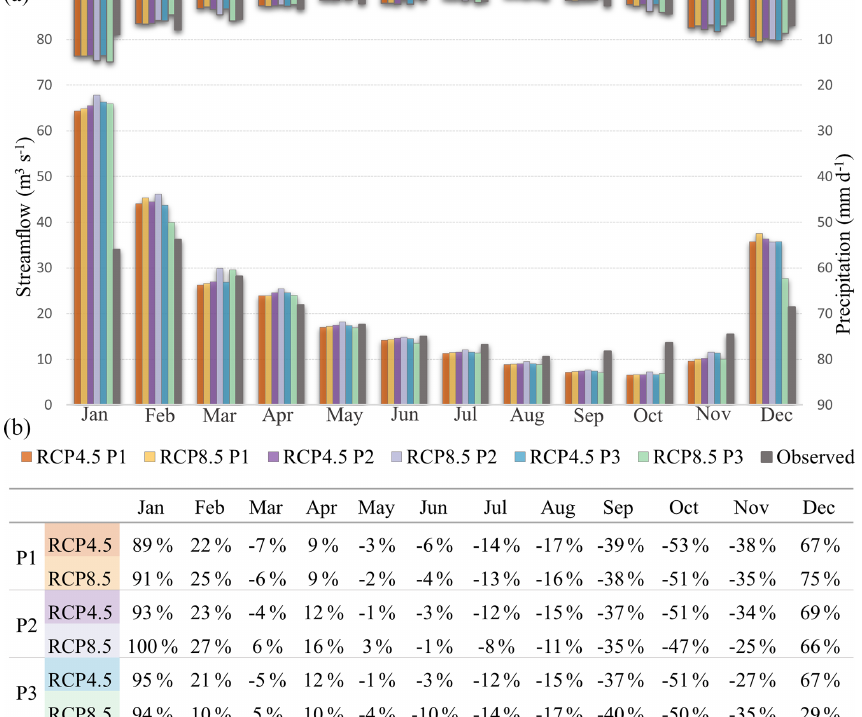
Hydrol. Earth Syst. Sci., 23, 4955–4968, 2019